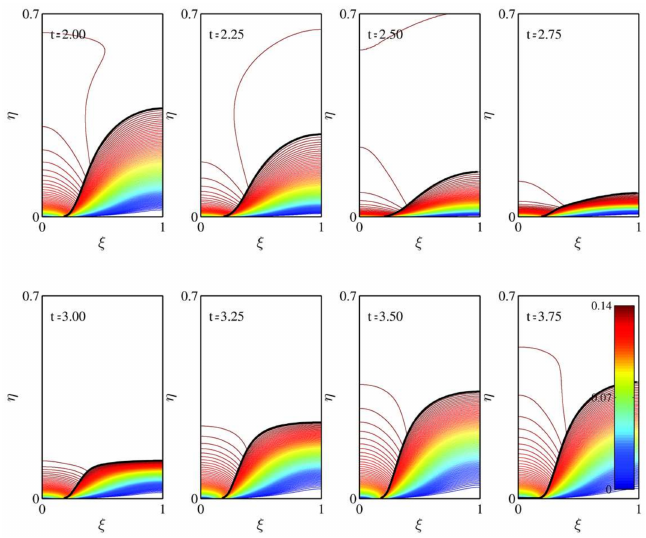
Figure 7. Evolution of normalized thermal field—without droplet grouping; the solid black lines represent the flame front.